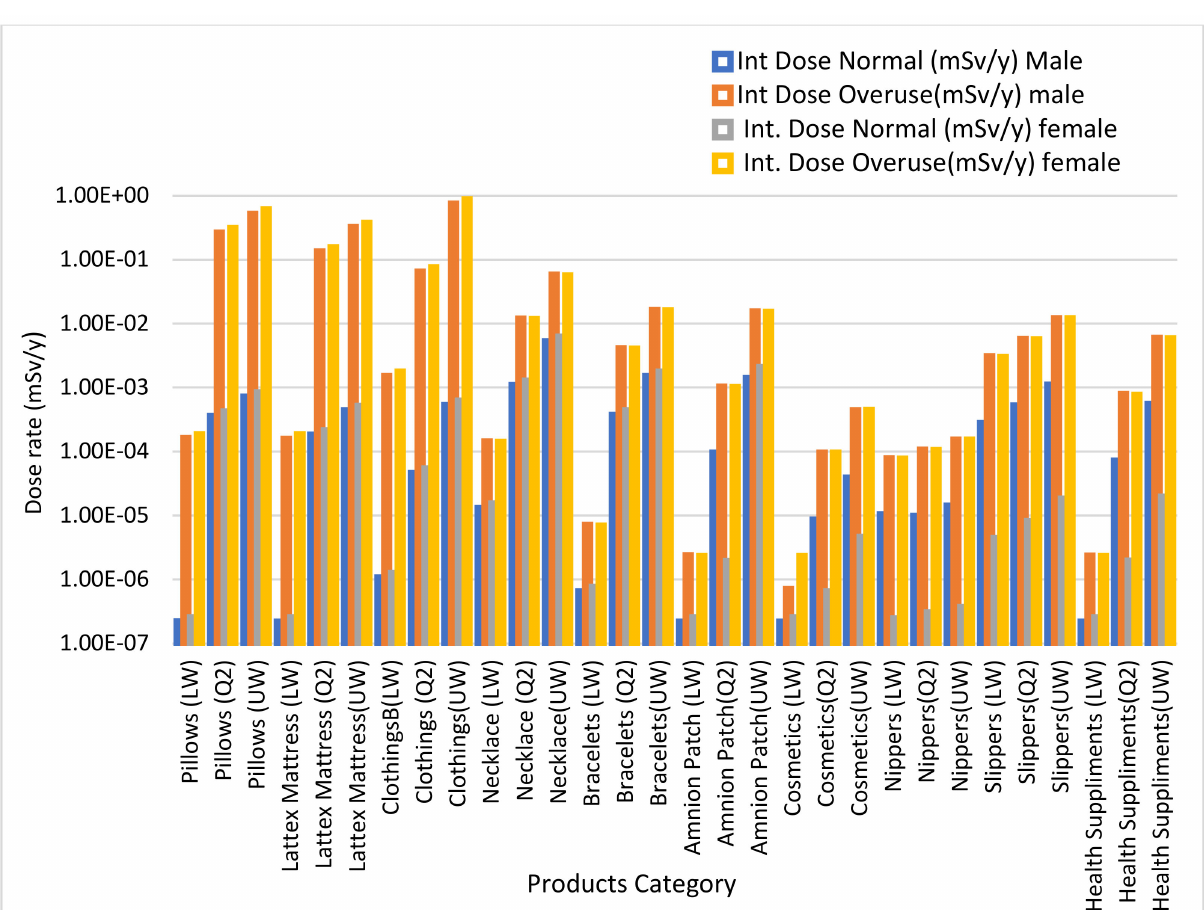
Figure 6. Internal dose during normal use and overuse for both phantoms